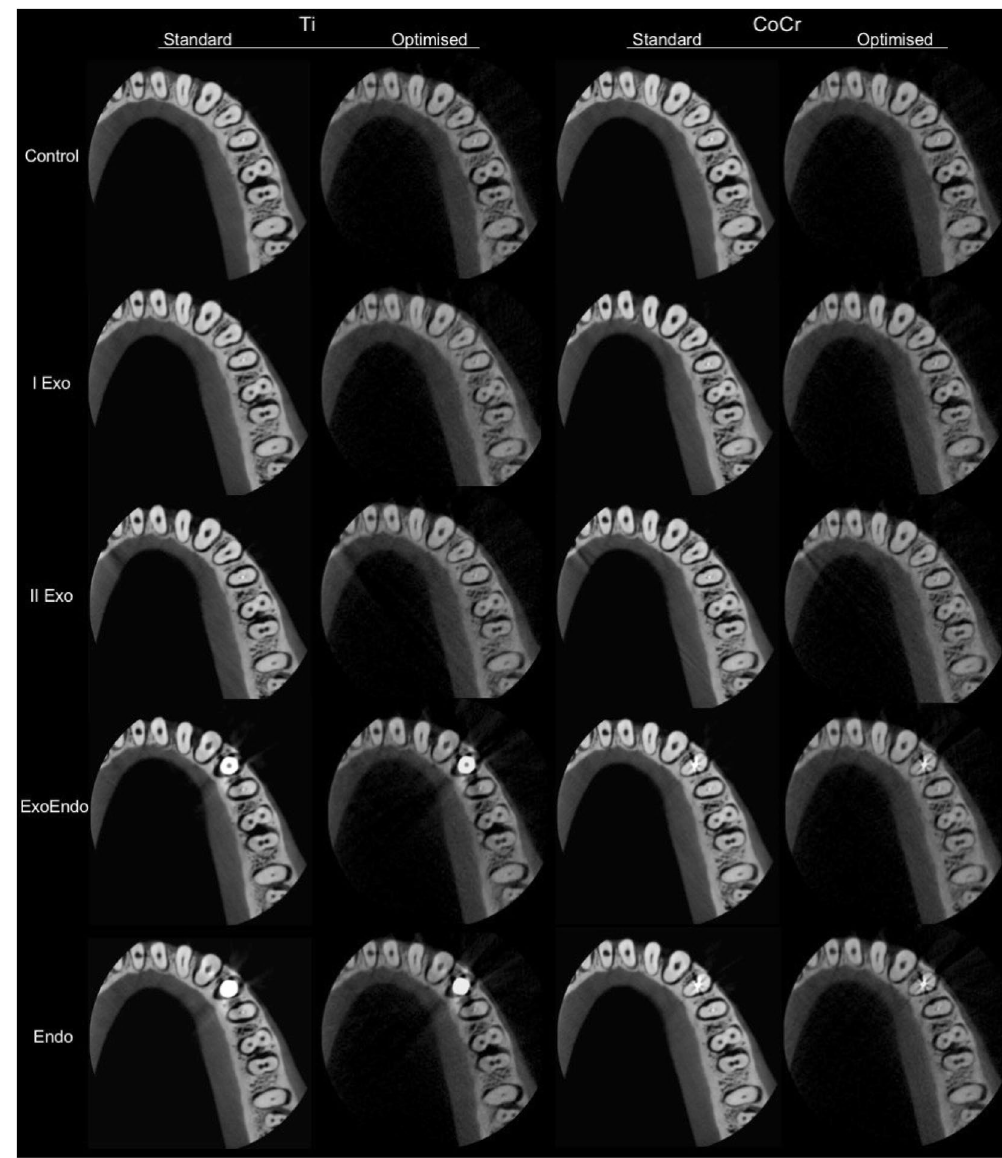
Figure 2. Representative CBCT axial reconstructions of the standard and optimised protocols in different dispositions of titanium implants and cobalt-chromium intracanal posts in the